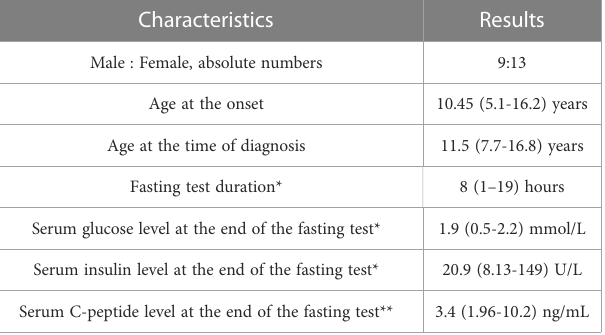
TABLE 1 Main clinical and biochemical parameters of 22 pediatric patients with insulinoma. Characteristics